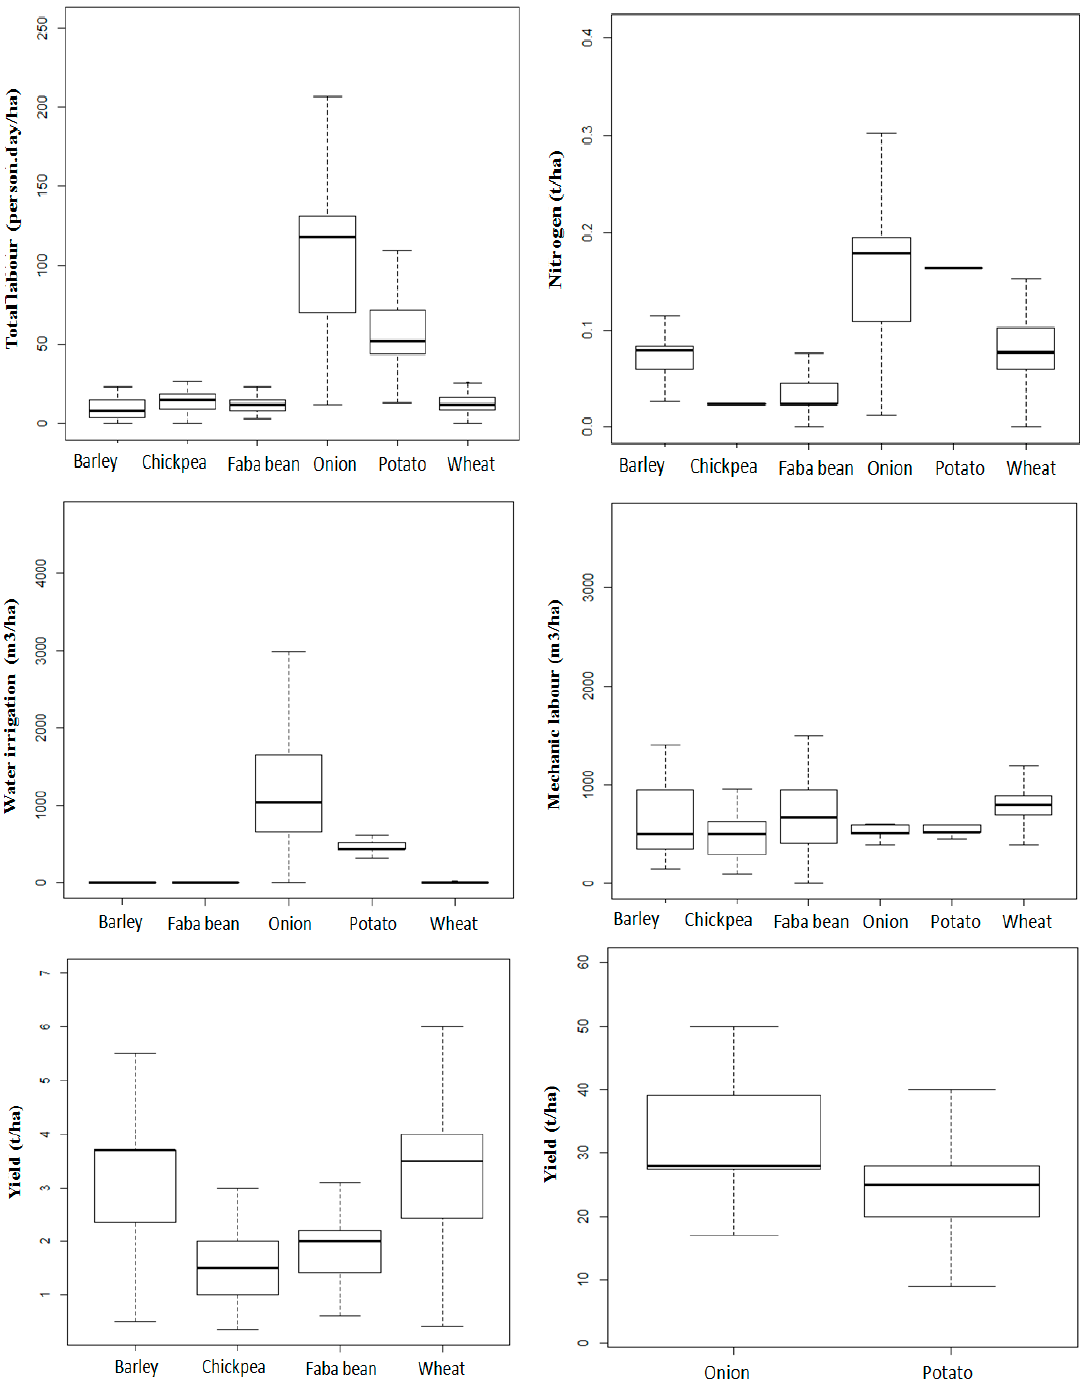
Figure 3. Box plots of nitrogen fertilizer, irrigation water, labour and yield per crop species in the study area.